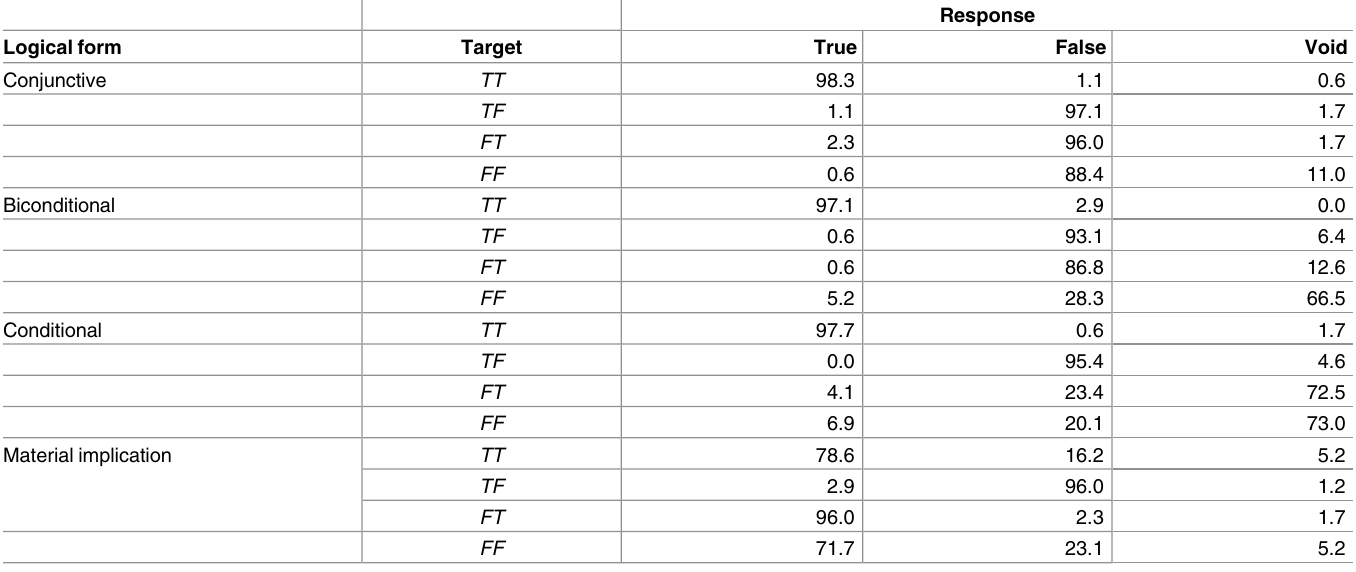
Table 2. Percentages for the Response Categories (True, False, and Void) in the Truth Table Task in Experiment 1.